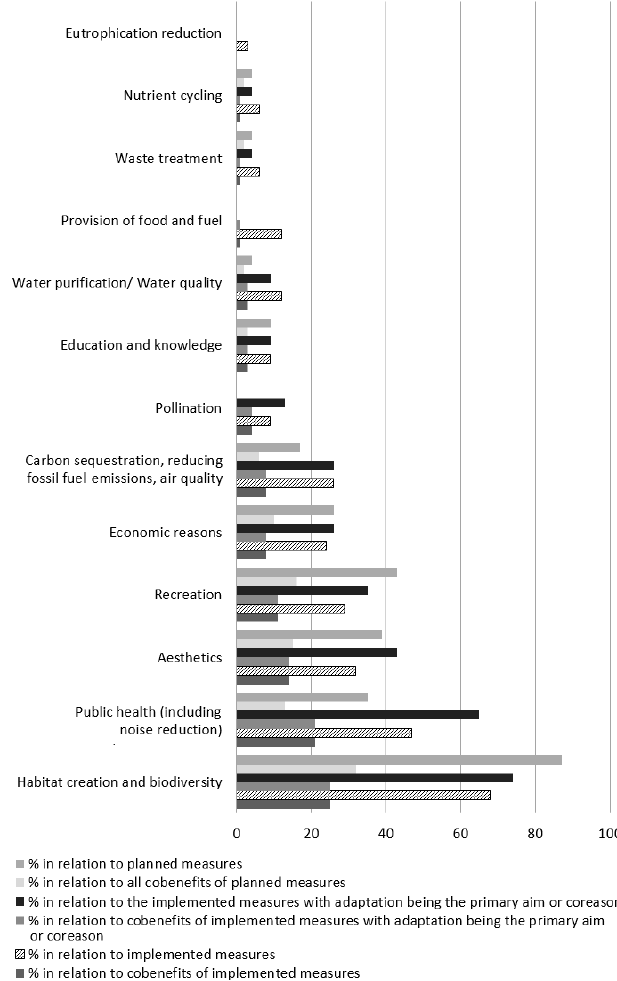
Fig. 7 . Cobenefits of identified measures. Multiple categorizations of single measures are